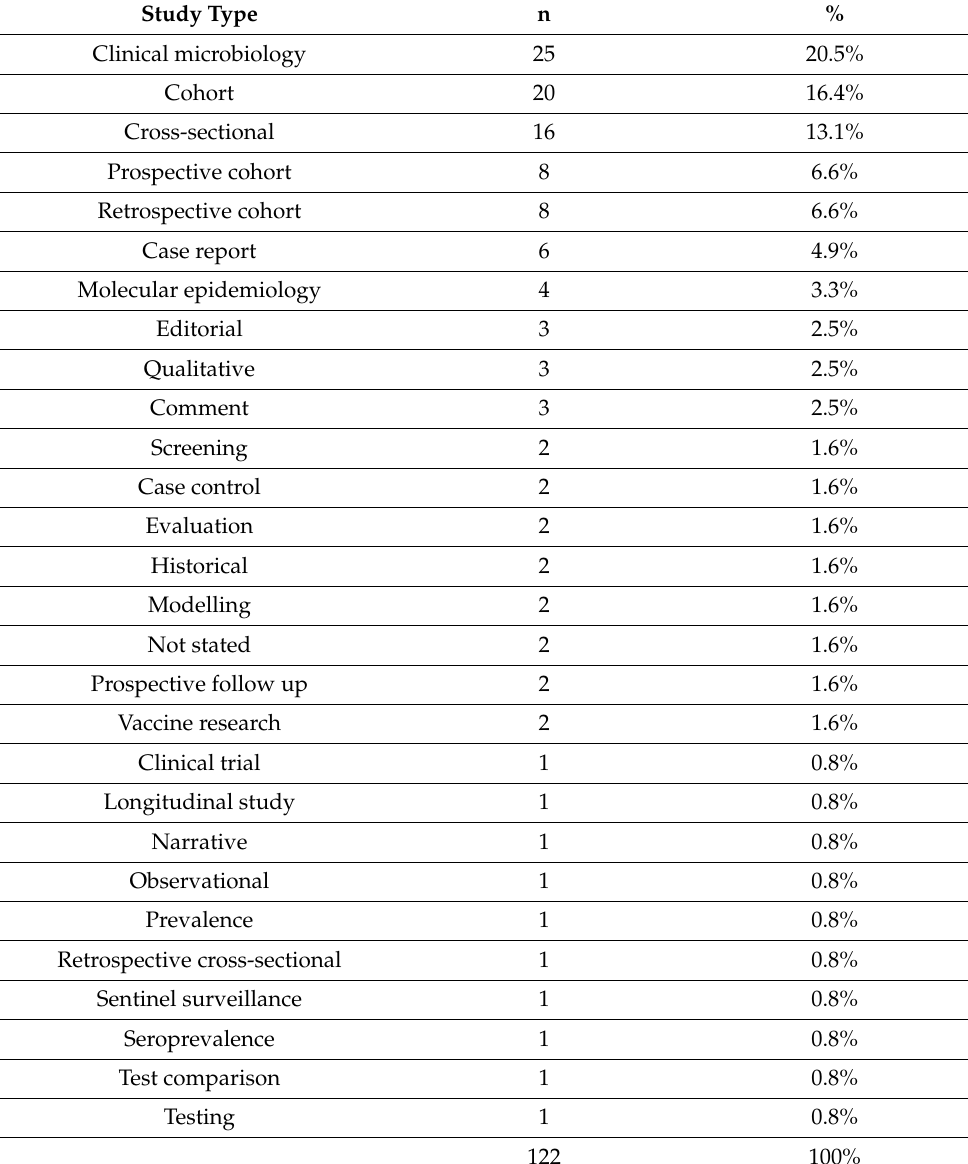
Table 1. Most common study types found (n =